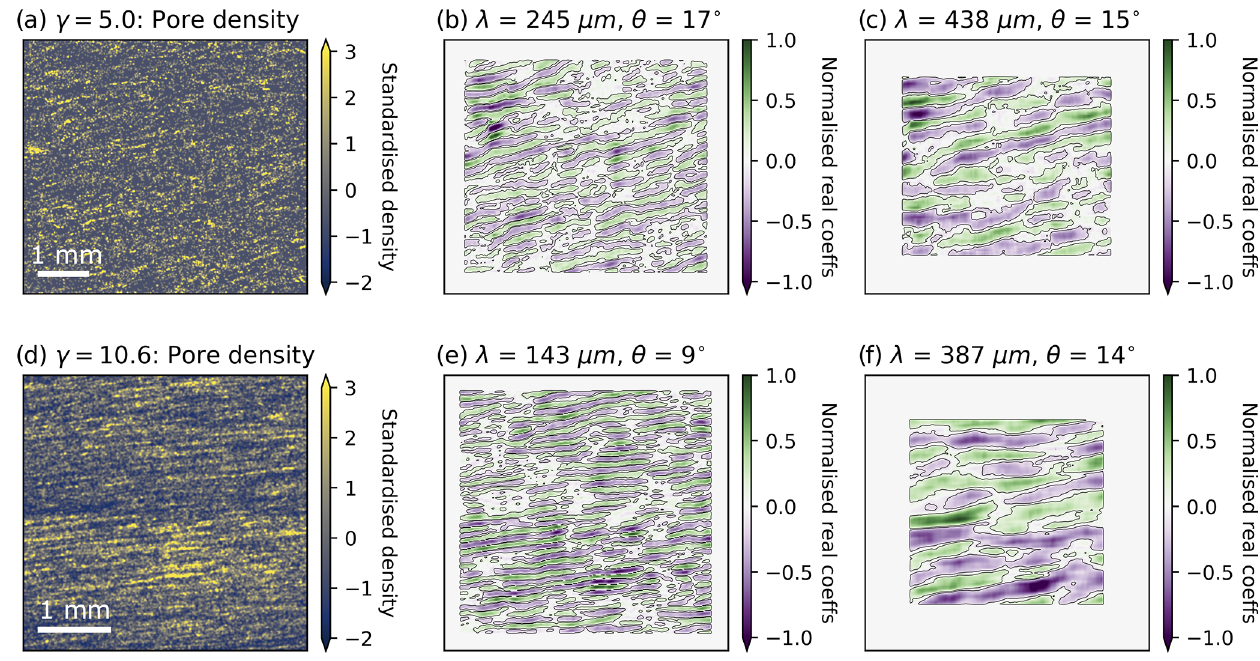
Figure 4. Visualisation of the results of the wavelet convolution with the pore density maps. The anisotropy identified by the dominant peaks in Fig. 3 are shown for the partly (a–c) and fully (d–f) recrystallised samples. For each convolution at each wavelength analysed, areas are defined where edge effects may occur. Data in these areas have been removed, which results in the white areas in the edge of (b) and (c) and (e) and (f) (see Sect. A6 for details). As before, the pointed ends of the colour bars refer to the fact that some data values are larger than the max and min of the colour